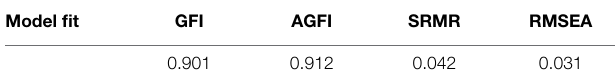
TABLE 4 | Model absolute fit measures. Model fit